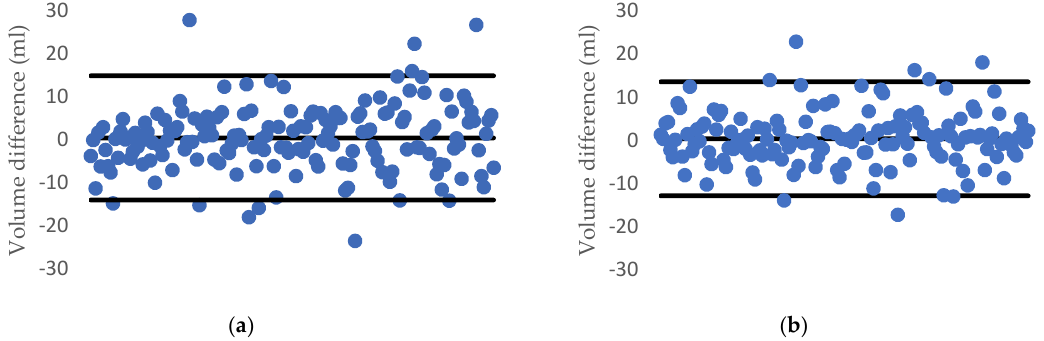
Figure 17. 1.96- σ plot for the volume di ff erence between the water displacement and our method: ( a ) a carrot and ( b ) a cucumber.